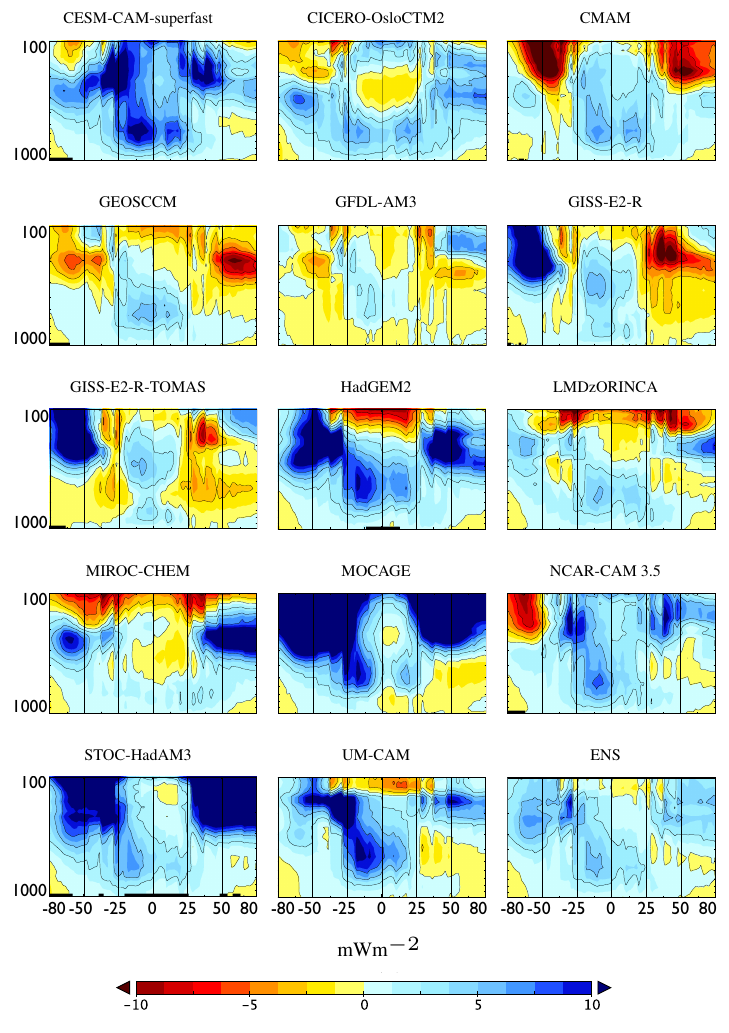
Fig. 3. Zonal distribution of ACCMIP OLR bias from tropospheric ozone, δ OLR j,m , from 2005-2010. The vertical scale is defined from 1000–100hPa discretized to TES pressure levels. Color scale is inverted to show that positive δ OLR j,m is a model low ozone bias relative to TES. Ensemble mean bias δ OLR l is denoted by ENS.